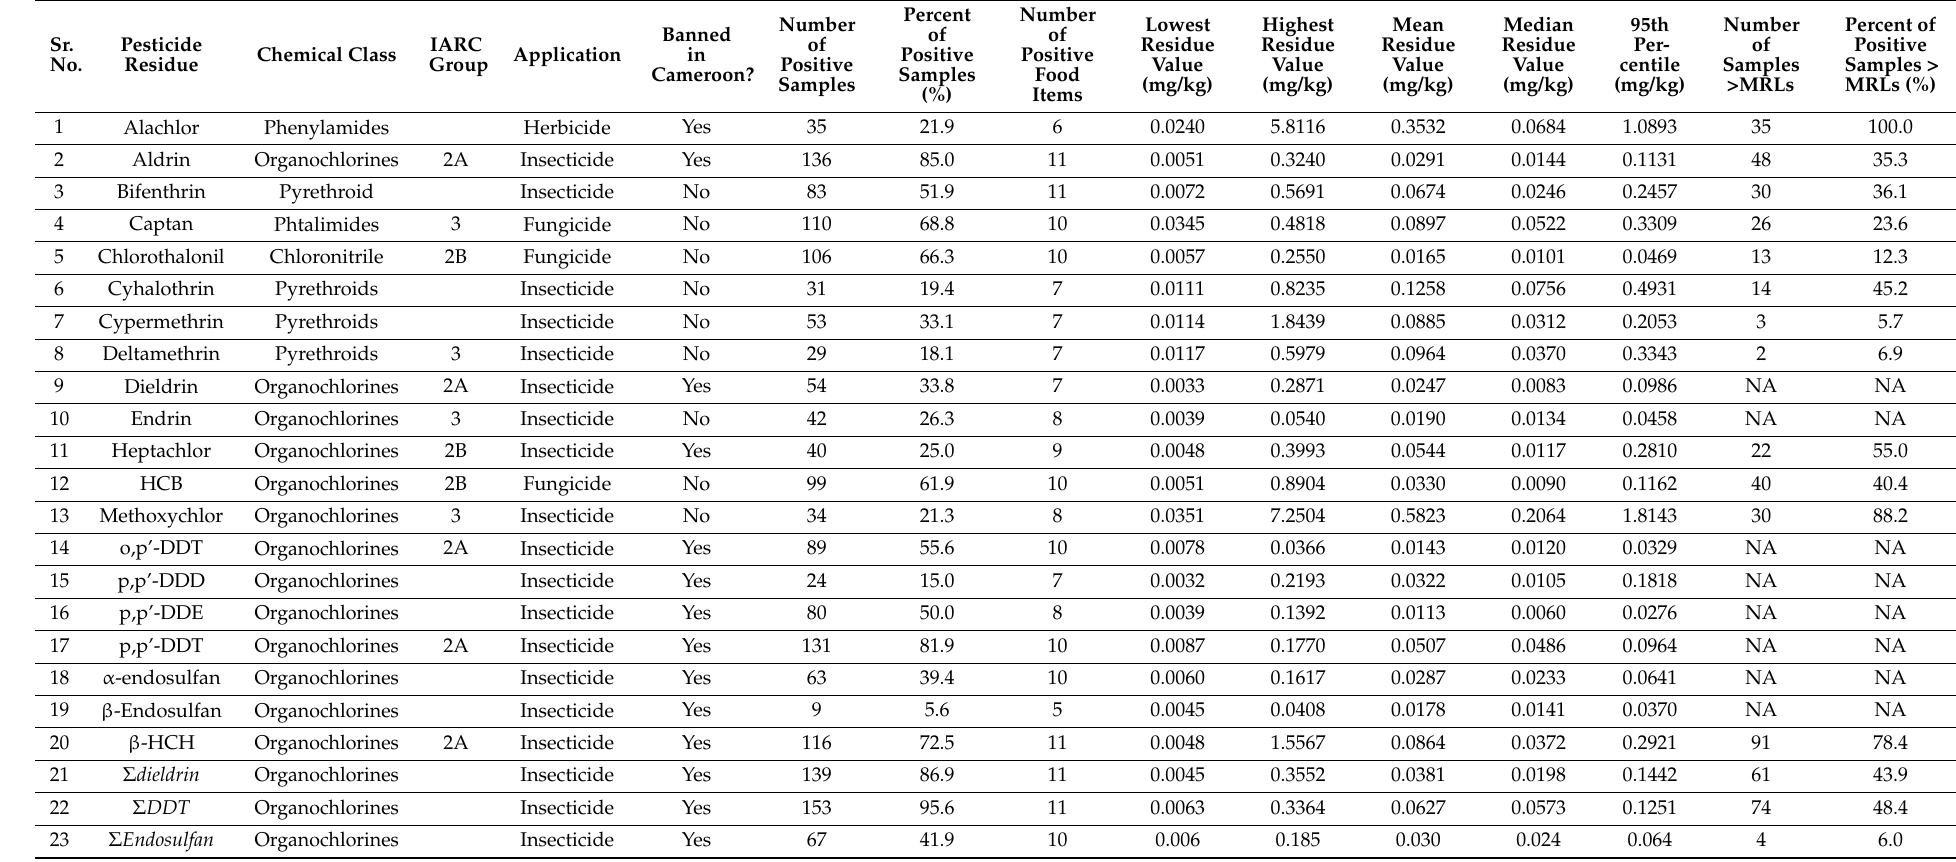
Table 1. Distribution of halogenated pesticide residues quantified in 11 food items from the 3 largest cities of